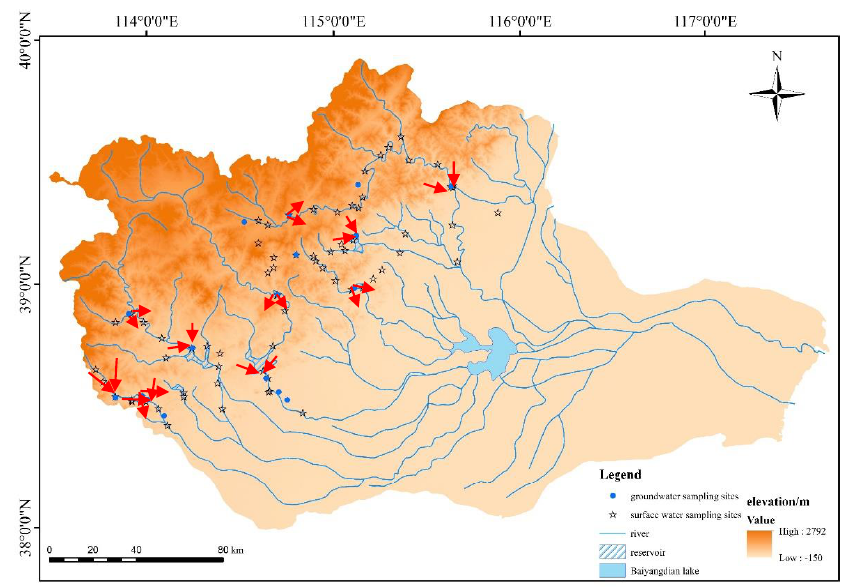
Figure 8. The relationship between surface water and groundwater transformation in the mountain- ous watershed of Daqing River. After the rainy season, the exchange of surface water and groundwater is frequent, and the isotope points of surface water and groundwater are close to the meteoric water line. This can indicate that both surface water and groundwater in the mountainous wa- tershed of the Daqing River are mainly recharged by rainfall. Therefore, it is initially de- termined that the declining runoff in the mountainous area is due to the continuous de- cline of the groundwater level in the piedmont plain. The hydraulic gradient between the mountainous area and the piedmont plain is becoming larger, the replenishment effect of the mountain transition zone to the piedmont plain is strengthened, and the mountain water resources are more often discharged downstream in the form of groundwater, which also leads to the further reduction of the surface water outcrop in the mountain area. 6. Conclusions The hydrochemical type of water in the research basin is mainly Ca-HCO 3− , which belongs to a group of low mineralization water, and the hydrochemical characteristics are relatively stable, indicating that the recharge source of each basin is mainly atmospheric precipitation. The δ 18 O value of the study watershed is affected by the altitude (elevation), and the δ 18 O value of the surface water samples has a decreasing trend with the decrease in the altitude, but the decreasing trend of the δ 18 O value of the groundwater sample is not obvious with the decrease in the altitude.